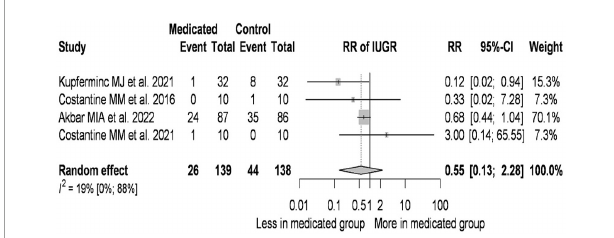
FIGURE4 Pravastatin treatment reduces the incidence of IUGR–forest plot.